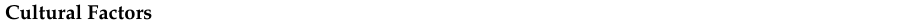
Table 2. Cultural and personal behavioural factors that reflect cultural preference towards the use of toilet and related facilities. These factors are drawn from many sanitation studies [53–73] and rarely have been considered in technical interventions aimed at reducing AR. Not all factors are relevant to SE Asia, but accounting for such factors is critical for ensuring public buy-in, especially with more rudimentary sanitation interventions for AR